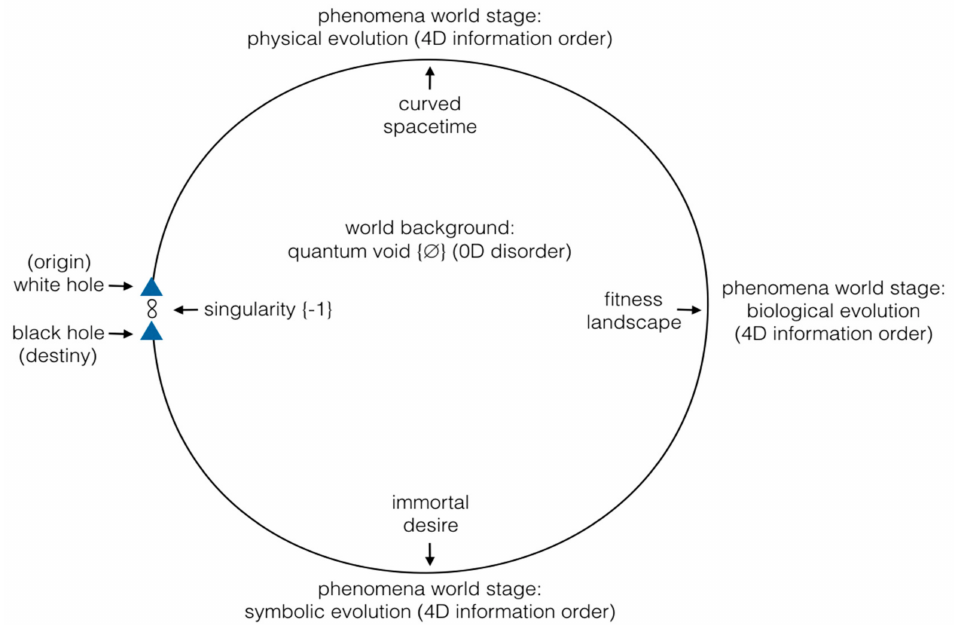
Figure 13. Cosmic evolution and dialectic connecting beginning and end. In this representation, we see the contemporary cosmic evolutionary process that can be divided between physical evolution of curved spacetime, biological evolution of fitness landscapes, and symbolic evolution of immortal desire. Here, although highly speculative, we can start to entertain a potential theoretical link between the mystery of the ordered astrophysical singularity at the beginning of spacetime and the mystery of the destiny of ordered evolutionary processes. From this link, we are asked to think the way in which the horizon of ideation can be possibly inscribed into the immanence of cosmic-physical processes via the inclusion of a type of extreme primordial and emergent curvature where evolutionary change can be reconciled with eternity. The true question here becomes the ultimate nature of the ‘eternity’. Here, it is negativized ( − 1) as absent in the historical process since its presence would nihilate our 4D existence. However, the possibility of the actualizing and perceiving higher super-symmetrical dimensions is mathematically real and experientially realizable given the known future technological possibility space available to future